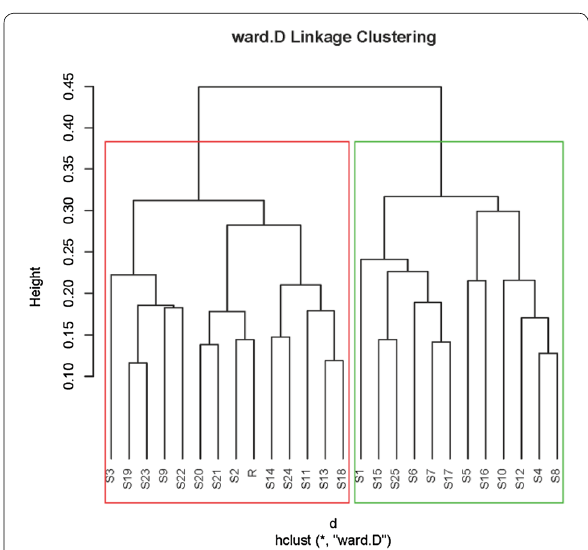
Figure 5 Clustering